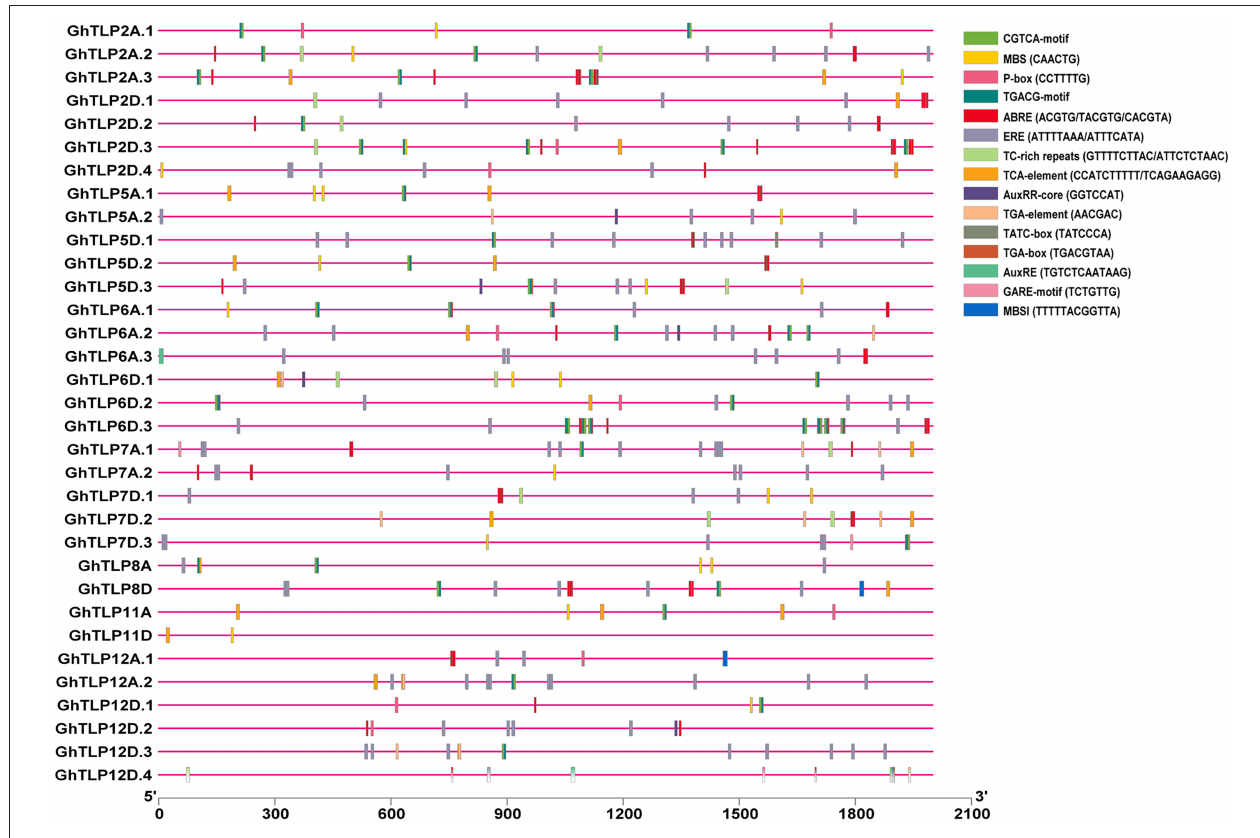
FIGURE 6 | cis -regulatory elements analysis of G. hirsutum TLP genes. The micro-parts in diverse colors are the putative elements sequence.